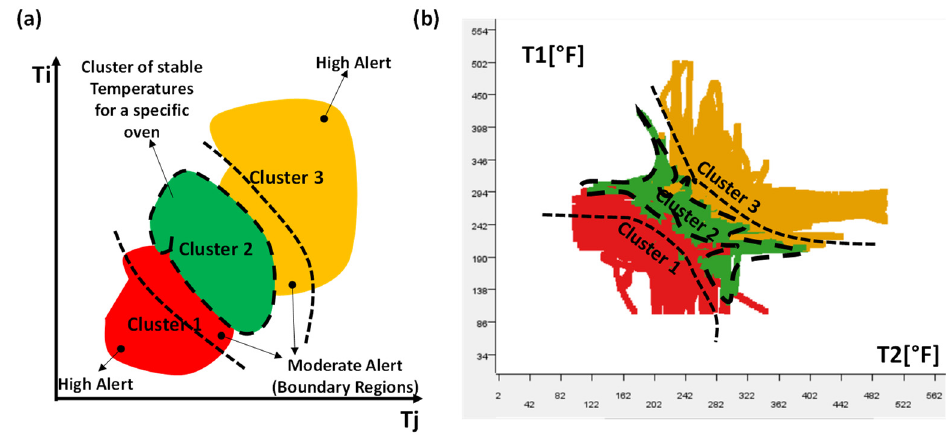
Figure 7. ( a ) Alerting risk map: theoretical clusters (k = 3) grouping temperature values of an oven. ( b ) Clusters and risk map estimated for the analyzed dataset [23].